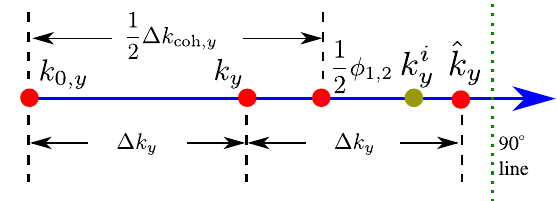
FIG. 10. Schematic drawing of the comparison on location of the phase advances to the phase shifts of envelope modes ϕ 1 . ; 2 k 0 is the phase advance without space charge; k is the depressed ;y y ˆ k for an equivalent KV beam; is phase advance shifted by Δ k y y the most depressed space charge shifted by 2 Δ k in a Gaussian y is the coherent space charge tune shift; k i is the beam; Δ k y coh ;y phase advance of an individual particle. The arrow indicates the direction of increasing space charge. Dashed line denotes the 90° phase advance line (in Fig. 7) during bunch